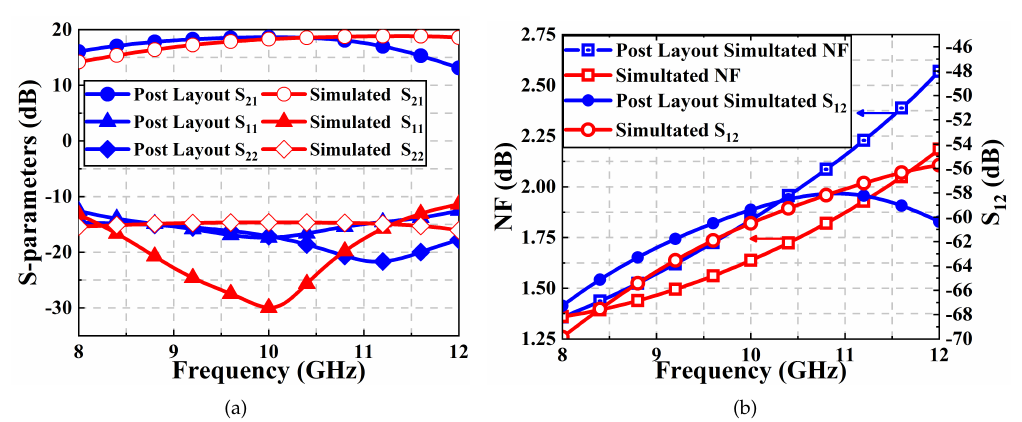
Figure 14. Layout of the proposed LNA.